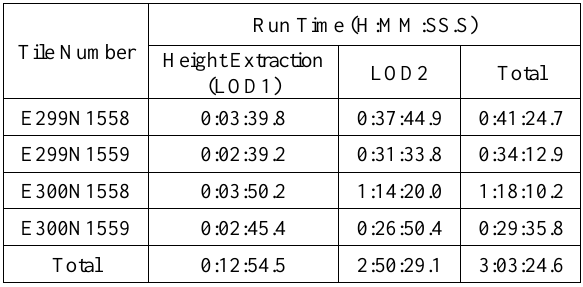
Table 7. Overall Processing Time (Test Bench 1).